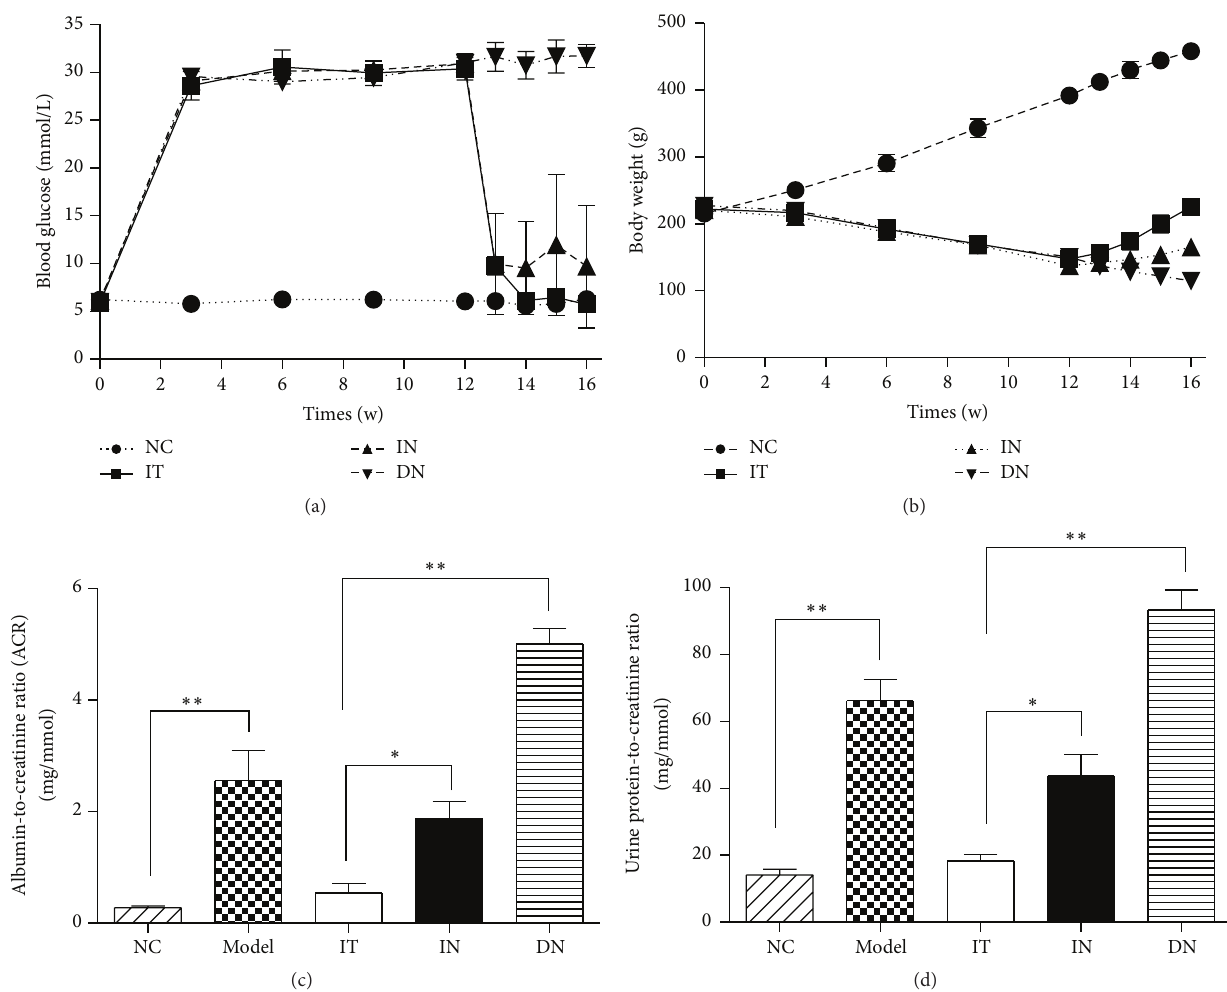
Figure 1: Blood glucose levels and body weights over 16 weeks and urinalysis results for each group. (a) Nonfasting blood glucose levels for each group. (b) Body weight changes over 16 weeks. (c) Random urine albumin-to-creatinine ratios (ACR) for each group, ∗ 𝑝 = 0.002 and ∗∗ 𝑝 < 0.001 . (d) Urine protein-to-creatinine ratios for each group, ∗ 𝑝 = 0.001 and ∗∗ 𝑝 < 0.001 . Model group: diabetic nephropathy model rats established at 12